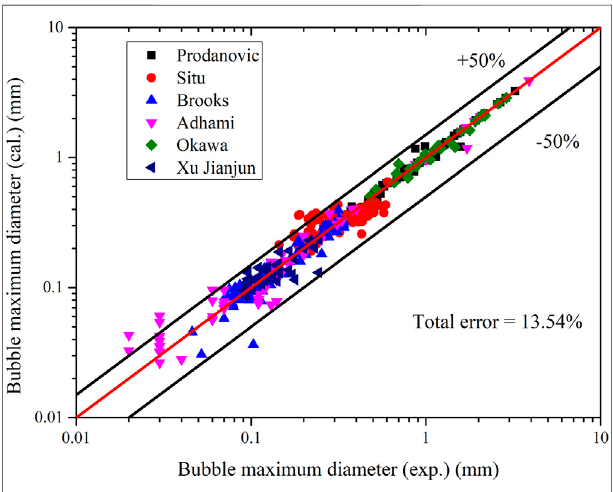
FIGURE 4 | Bubble maximum diameter predicted by the ANN